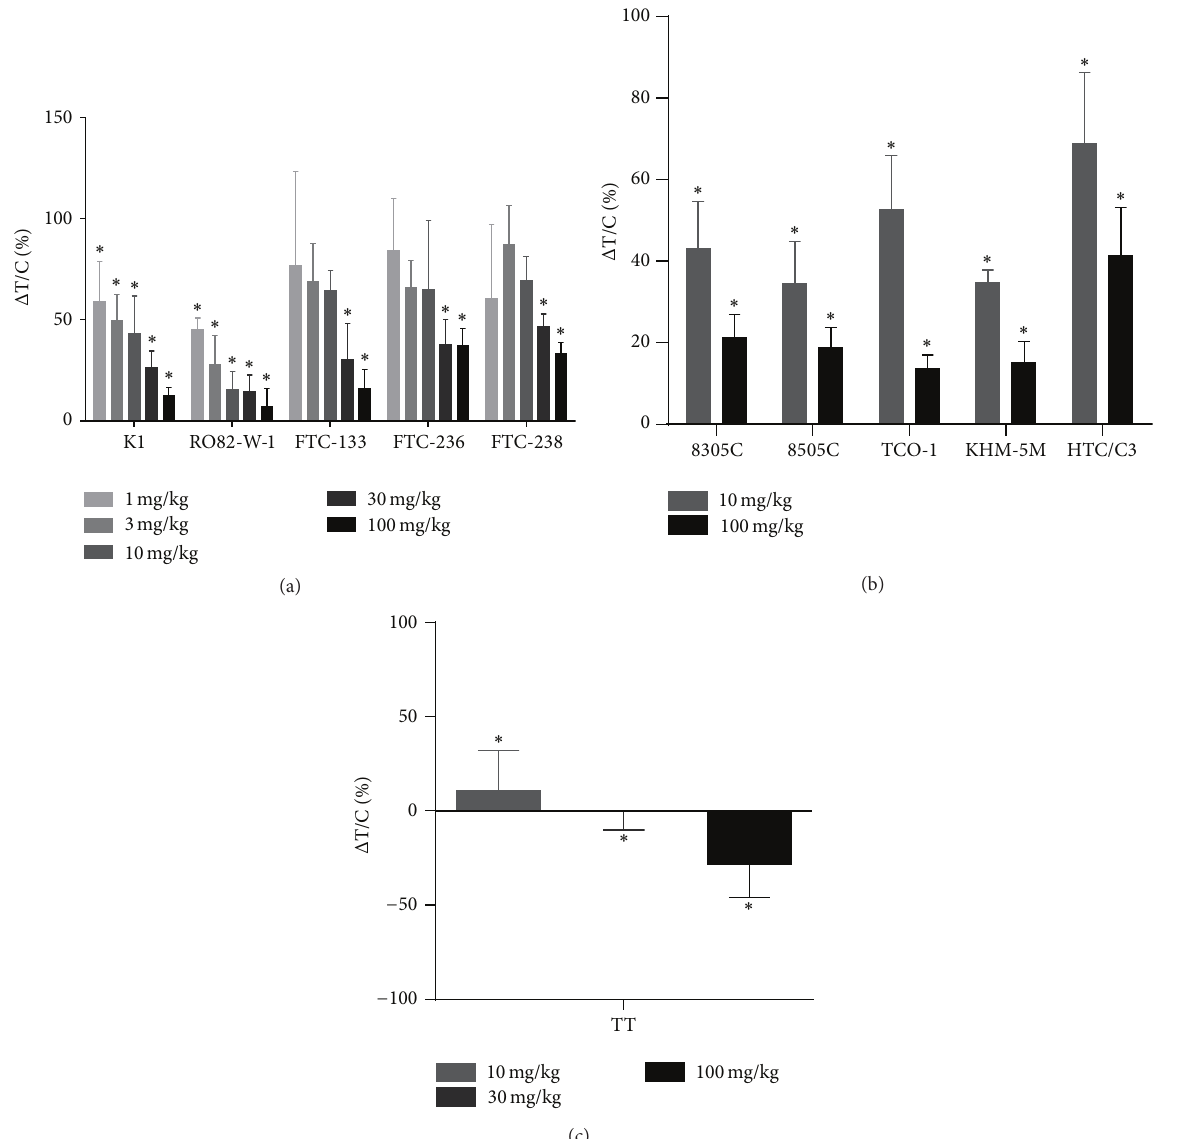
Figure 1: Antitumor activity of lenvatinib in human thyroid cancer xenograft models in nude mice. Nude mice bearing tumor xenografts were treated orally once daily with either vehicle or lenvatinib at the indicated doses when tumor volumes reached between 100 and 300 mm 3 (day 1). Each group consisted of 5 mice. The change in tumor volume in the treated group relative to that in the control group Δ𝑇/𝐶 (%) was calculated as (Δ𝑇/Δ𝐶) × 100 %, where Δ𝑇 and Δ𝐶 are the change in tumor volume for the treated and vehicle control group, respectively. (a) DTC xenograft models. Δ𝑇/𝐶 on day 15. (b) ATC xenograft models. Δ𝑇/𝐶 on day 15. (c) TT xenograft model. Δ𝑇/𝐶 on day 29. Data are shown as means ± SD. ∗ 𝑃 < 0.05 compared with vehicle-treated